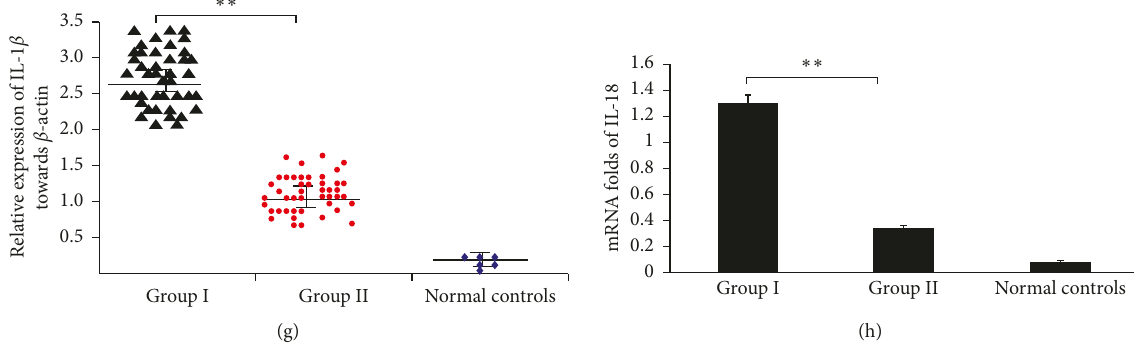
Figure 2: MMC suppresses the activation of NLRP3/Caspase-1 pathway in pterygium tissues. (a) NLRP3 expression in typical tissue sections from primary pterygium patients with or without MMC injection was determined by immuno-histochemistry analysis. Data were demonstrated as corresponding images (left panels) and staining score of NLRP3 with means ± SD (right panels). ∗∗ P < 0 . 01. (b) Comparison of NLRP3 protein levels between group I and group II in primary pterygium patients was carried out by western blotting analysis. The expression levels of NLRP3 were normalized to those of β -actin, the horizontal line represents the median value, and the error bars indicate the SEM. ∗∗ P < 0 . 01. (c) The positive relation between fibroblasts numbers and NLRP3 expression was determined by Spearman’s correlation analysis. β -Actin protein was used as internal reference (Spearman’s R � 0.663, ∗ P < 0 . 05). (d, e) The protein expression of Caspase-1 and Cleaved Caspase-1 in group I and group II patients was determined by western blotting analysis. Data are shown as representatives (d) or relative densities compared with β -actin from three independent experiments with means ± SD (e) ∗∗ P < 0 . 01 and # P > 0 . 01. (f) The expression of IL-1 β in primary pterygium patients from group I and group II was determined by immuno- histochemistry analysis. Data are represented as representatives (left panels) or means ± SD of score staining of IL-1 β (right panels). ∗∗ P < 0 . 01. (g) Relative gray values contrasted with β -actin assessed by western blotting analysis from three independent experiments with means ± SD. ∗∗ P < 0 . 01. (h) The mRNA expression of IL-18 in pterygium tissues from group I and group II was measured by real-time PCR analysis. Data are represented as the relative expression towards GAPDH of means ± SD in three independent experiments. ∗∗ P < 0 . 01. Normal corneal tissues were used as controls in all of above